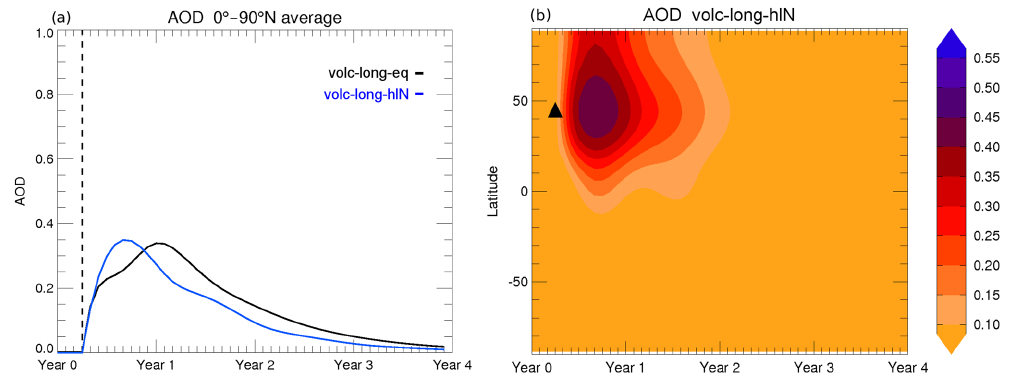
Figure 4. Consensus forcing for the volc-long-hlN experiment. (a) Northern Hemisphere average aerosol optical depth (AOD) at 550nm produced by the Easy Volcanic Aerosol (EVA) module for a 56.2Tg equatorial eruption (volc-long-eq, black line) and for a 28.1Tg SO 2 Northern Hemisphere extratropical eruption (volc-long-hlN, blue line). (b) Time–latitude plots of the AOD at 550nm from EVA for the 28.1Tg SO 2 Northern Hemisphere extratropical eruption. The black triangle shows latitudinal position and timing of the